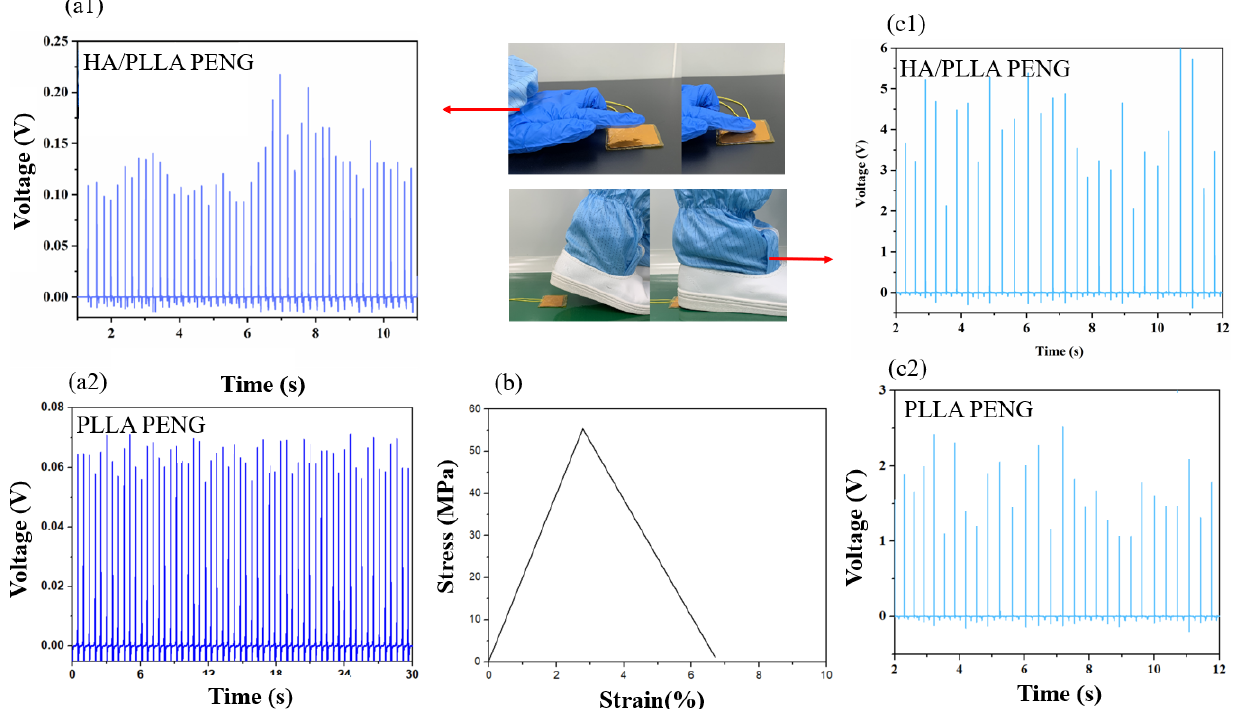
Figure 6. ( a1 , a2 , c1 , c2 ) Output performances of PLLA and HA/PLLA PENG under beating and treading conditions; ( b ) stress–strain curves of HA/PLLA